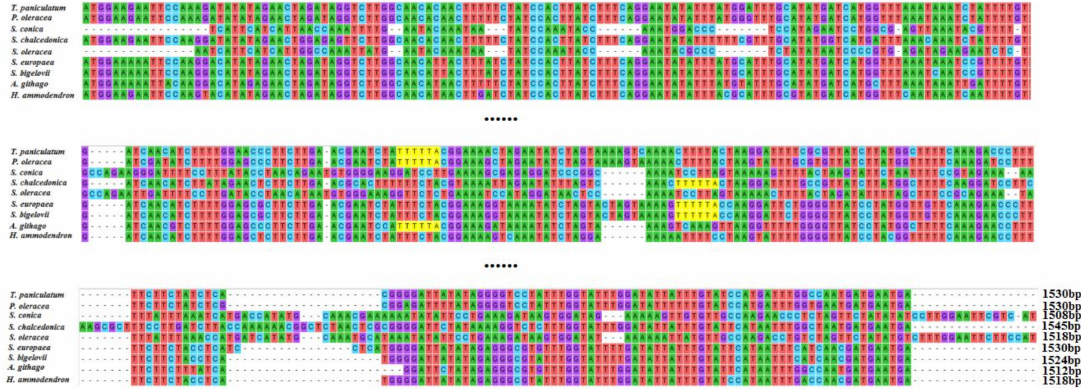
Figure 4. Sequence alignment of matK among nine species cp genome in Caryophyllales. As the matK gene are too long, only the sequences with greater variation were shown here.